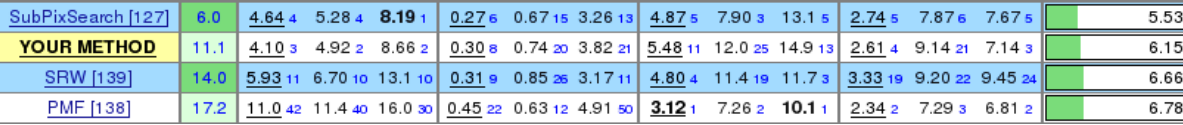
Figure 10. Results from the Middlebury evaluation platform for the 0.75 pixel threshold. Columns record from left to right: method; average rank; errors for the Tsukuba , Venus , Teddy , Cones stereo pairs; and average percent of bad pixels (errors are recorded for cases of non-occluded pixels, all pixels, discontinuities). Date of evaluation: January 30,